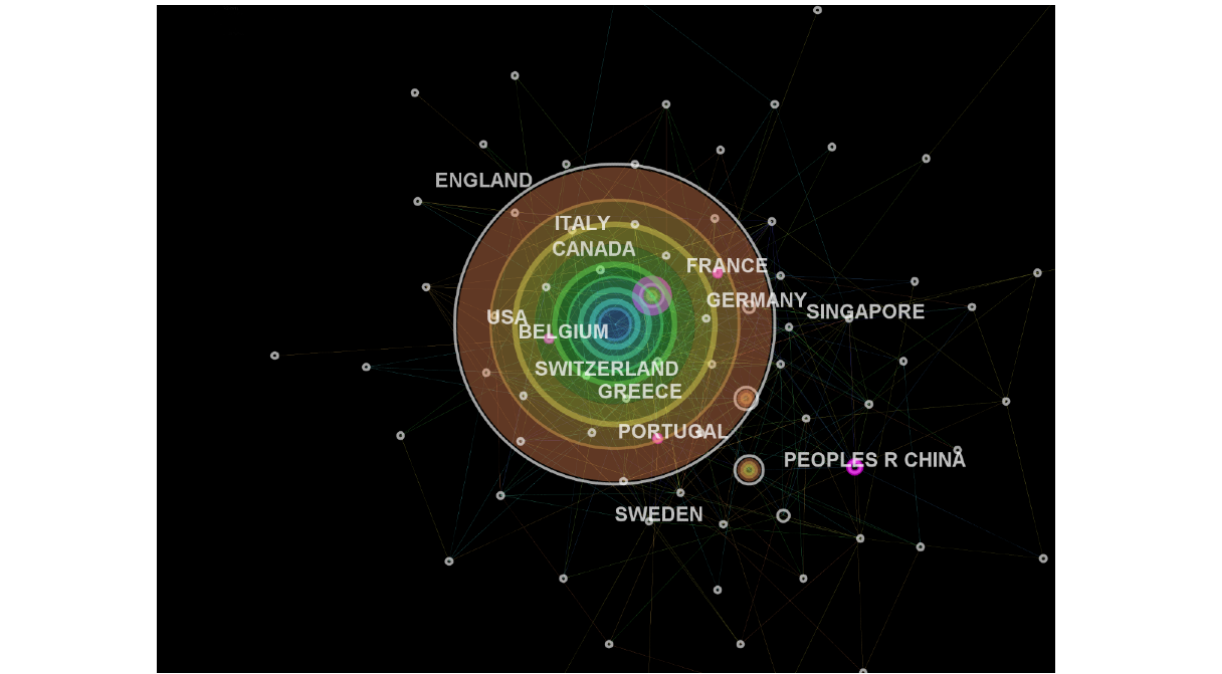
Figure 2. Regional collaborative networks in the area of telemedicine research. Peoples R China: People’s Republic of China; USA: United States of America.